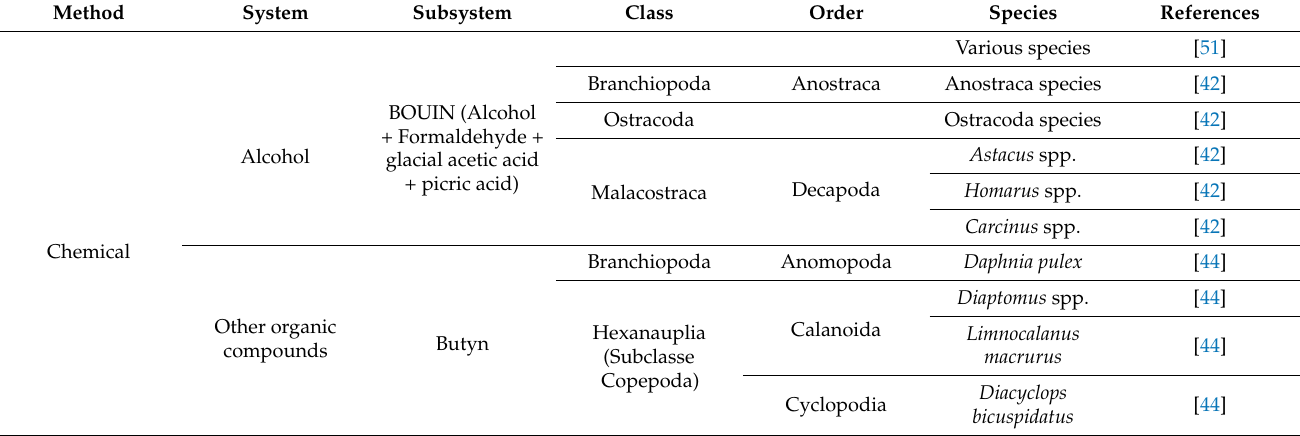
Table 4. Methods suggested as unsuitable for use as anesthetics in